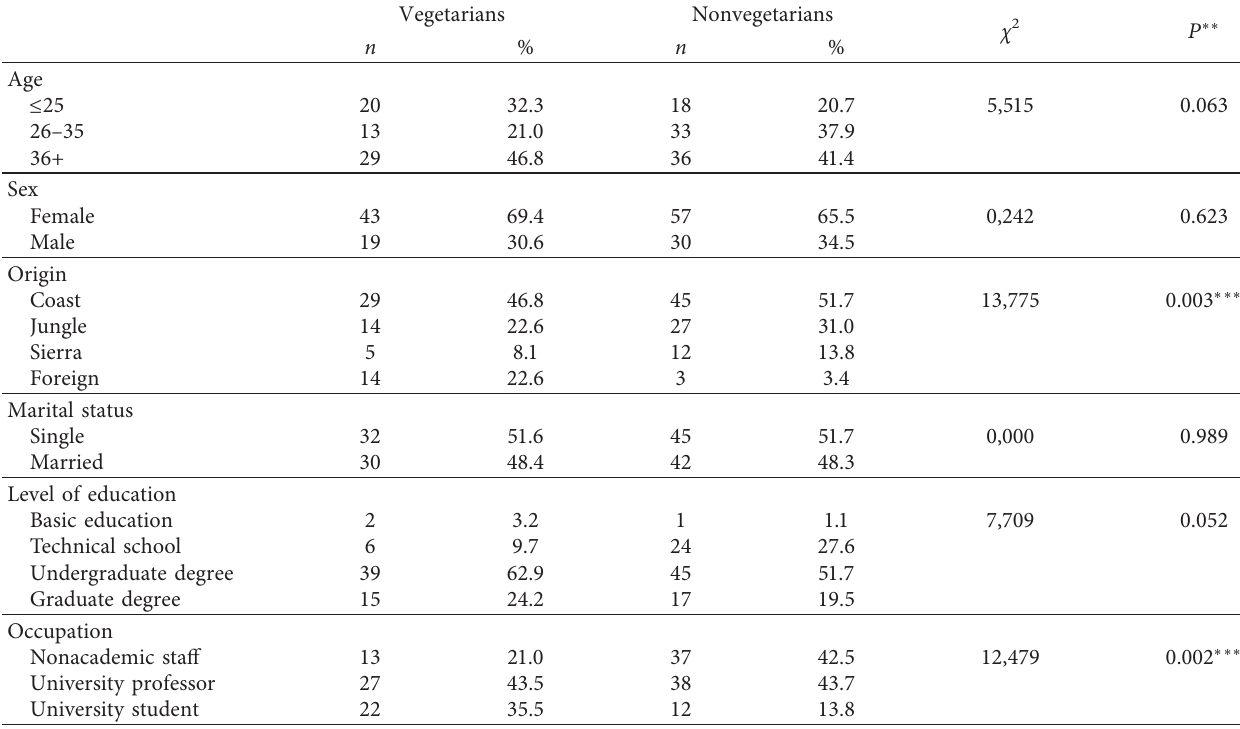
Table 1: Sociodemographic characteristics of vegetarians and